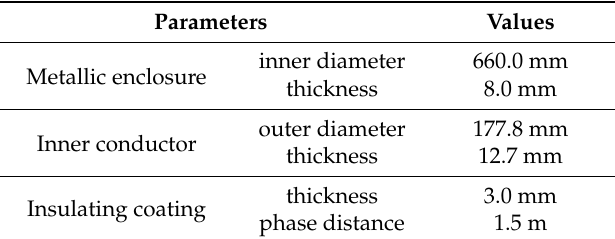
Table 1. Typical dimensions of an 800 kV